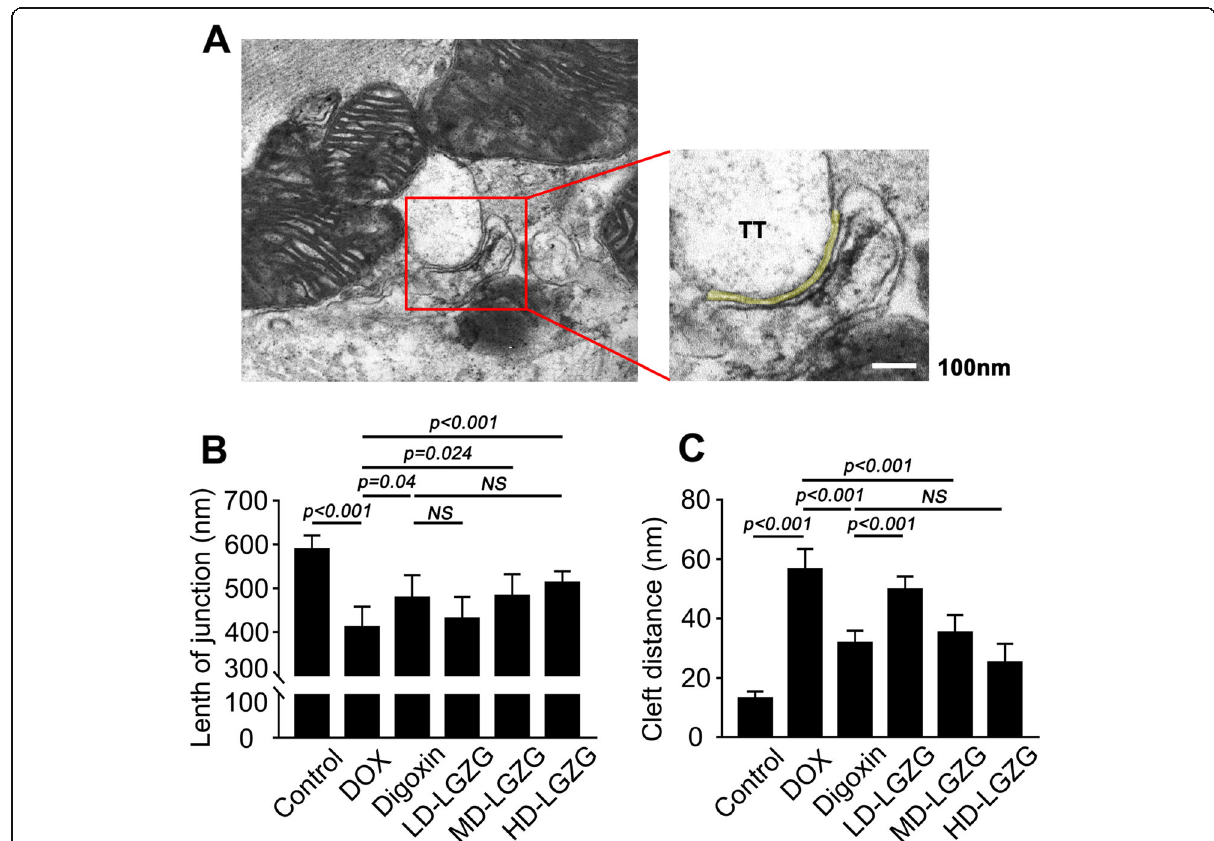
Fig. 4 LGZG improved TT-SR microstructural remodeling. ( a ) Representative cardiac TEM images of cardiac tissue from the control group showing selection of a region-of-interest. The junction region (left, red box) was selected and analyzed (right). The TT-SR junctional cleft is marked in yellow. The cleft distance and length of TT-SR junctions were measured as the curvilinear width and length of the yellow line. The average cleft distance and length of junctions are shown in ( b ) and ( c ). Data are mean ± SEM, n = 8. NS, not